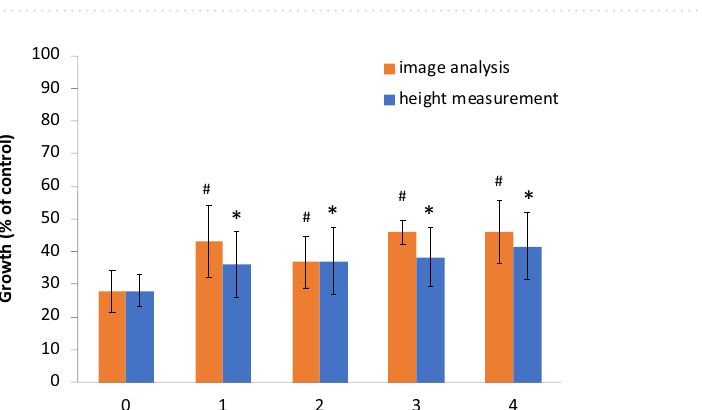
Figure 8. Oatmeal sprouts grown for identical amount of time on sieves with soil and Alginate/PCL granules which were washed with amounts of water that represent 0 to 5 rainy seasons. Control contains no granules (CRL); each treatment is labelled with the number of rainy seasons of pre-washing that were used in the experiment.